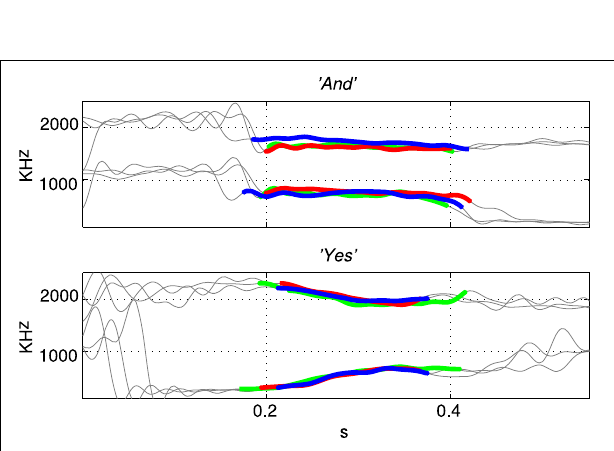
FIGURE 4 | Formant tracks extracted using LPC for three examples of two different stimuli “And” and “Yes.” Sections of the individual stimuli corresponding to vowels are indicated by thicker red, green, and blue segmemts this Figure clearly shows that there is some variation in the formant tracks among sets of stimuli of the same class even when recorded from a single speaker.